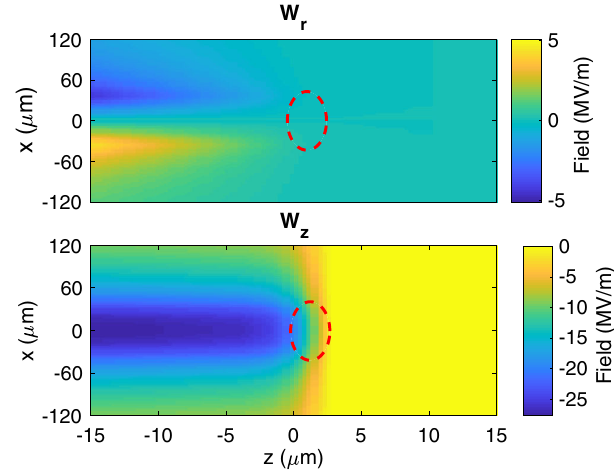
FIG. 7. Simulated radial (top) and longitudinal (bottom) plasma wakefield produced into the APL by the witness bunch. The red dashed ellipse shows the rms size of the witness bunch.